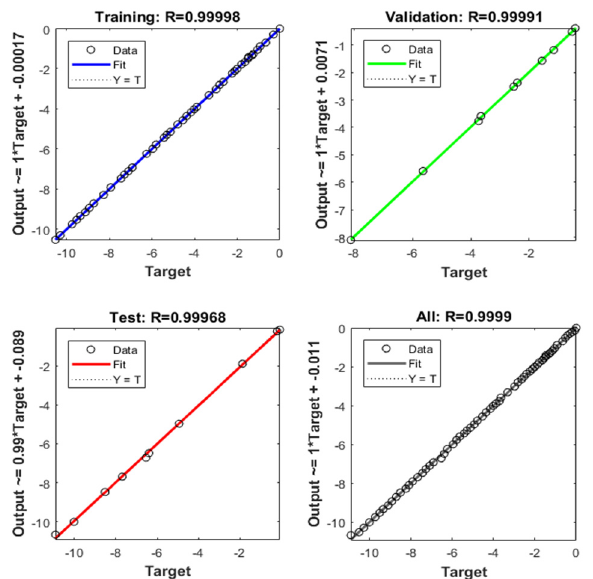
Figure 10. The correlation value of laboratory data and the ANN method (BRC-1 beam).